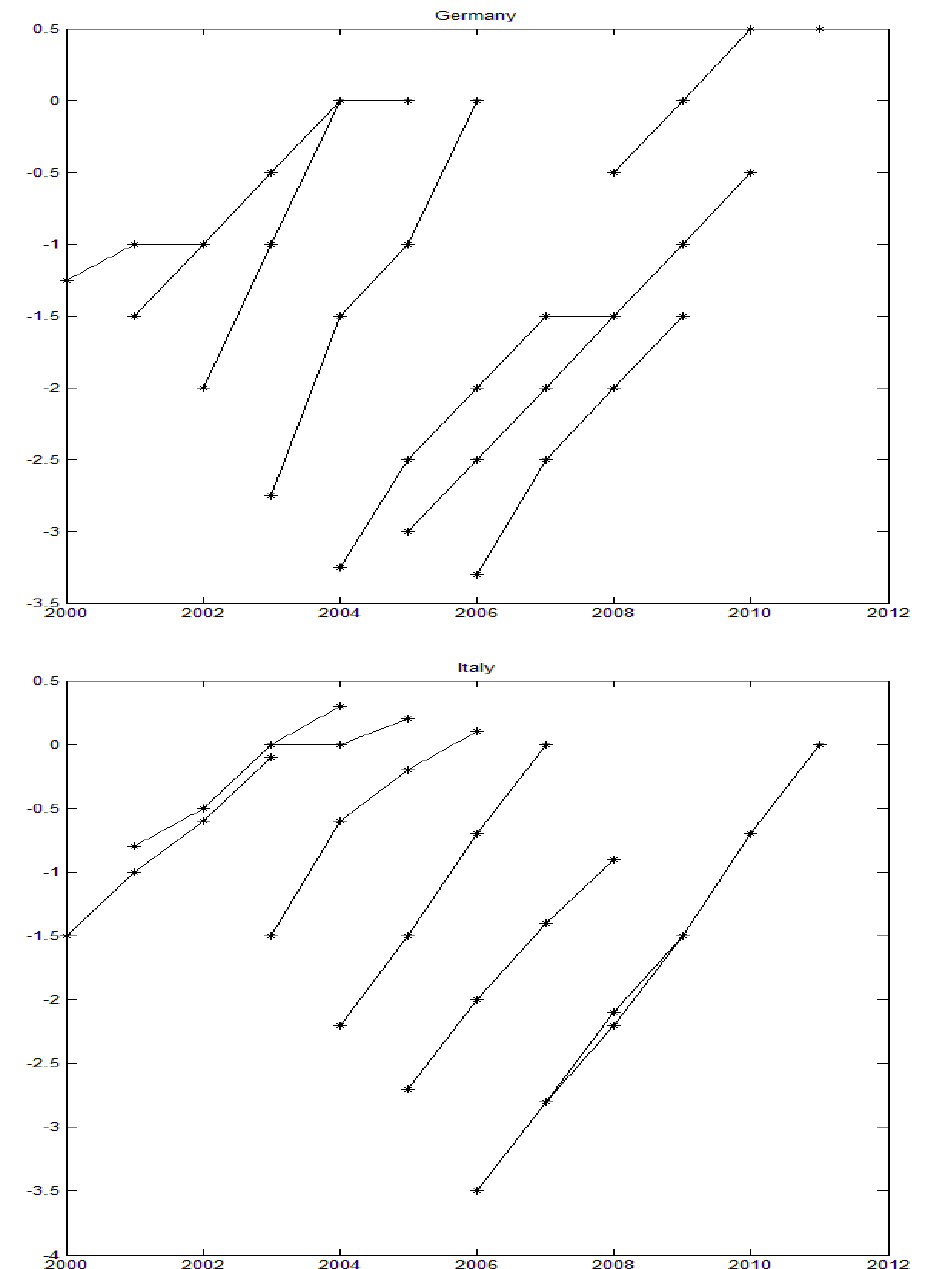
Figure 1. Announced deficit plans for Germany and